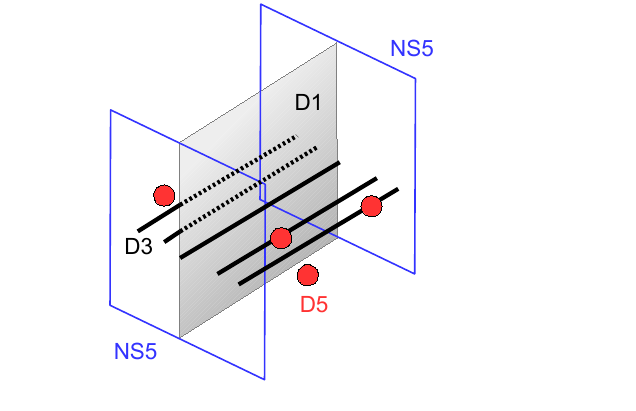
Figure 35 . Brane setup in the 3d space ( x 3 ; x 7 ; x 8 ) with a D1 string stretched between the two NS5s and intersecting a D3 brane. In this example there are N = 5 D3s and N f = 4